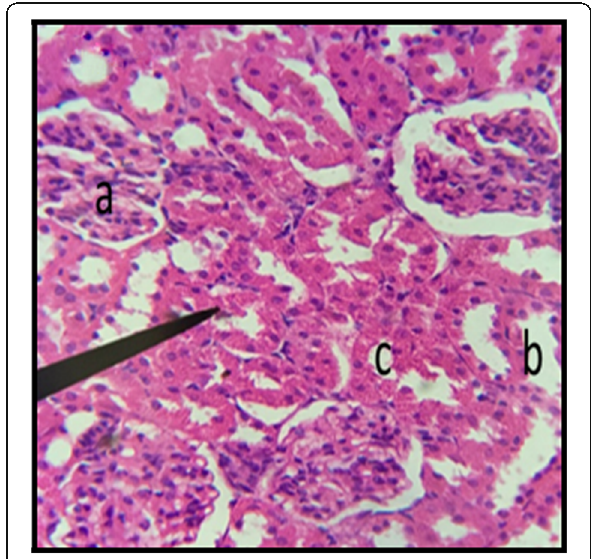
Fig. 3 Kidney Section of Male Rat (Control) X400. a normal glomerulus of control male rat, b normal distal tubules, c normal proximal tubules